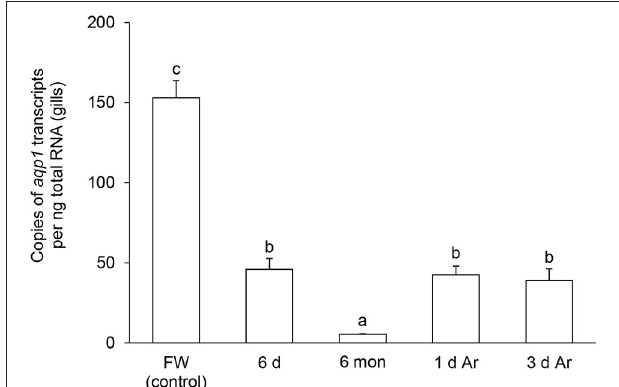
FIGURE 6 | The absolute quantification of mRNA expression level (copies of transcript per ng total RNA) of aquaporin 1 ( aqp1 ) in the gills of Protopterus annectens kept in fresh water on day 0 (FW; control), after 6 days (d; induction phase) or 6 months (mon; maintenance phase) of aestivation, or after 1 or 3 d of arousal (Ar) from 6 mon of aestivation. Results represent means ± S.E.M ( N = 4). Means not sharing the same letter are significantly different ( P < 0.05).